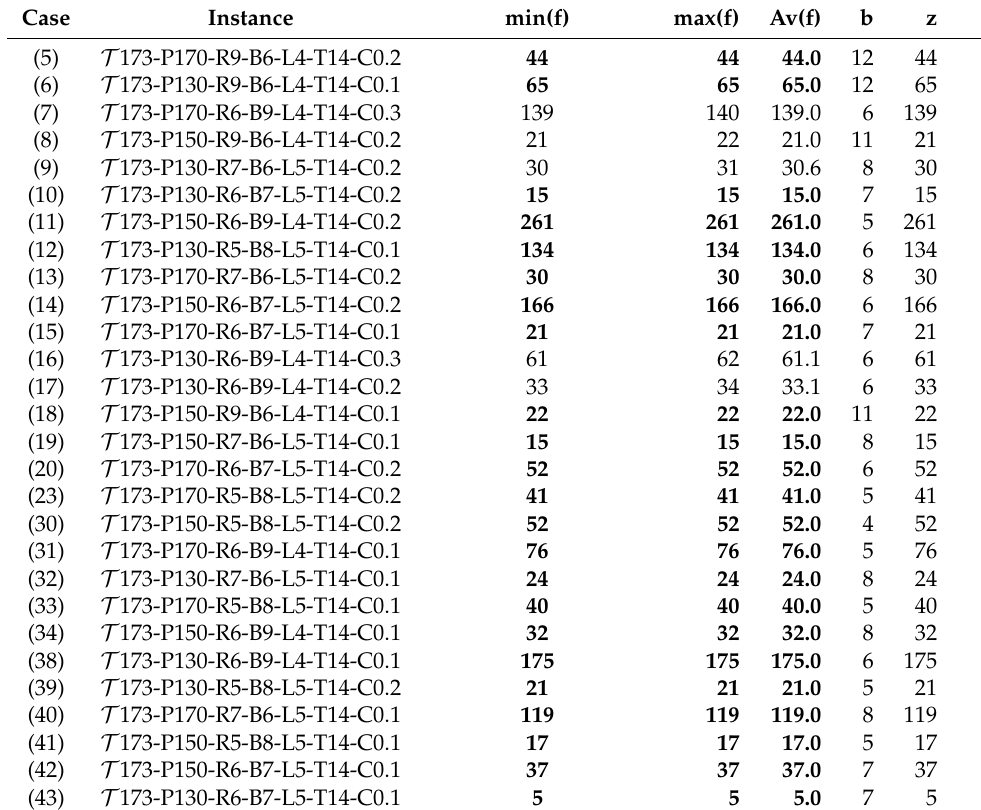
Table 7. Heuristic results for optimally solved problem instances. Results in bold highlight when max(f) = min(f) = Av(f).